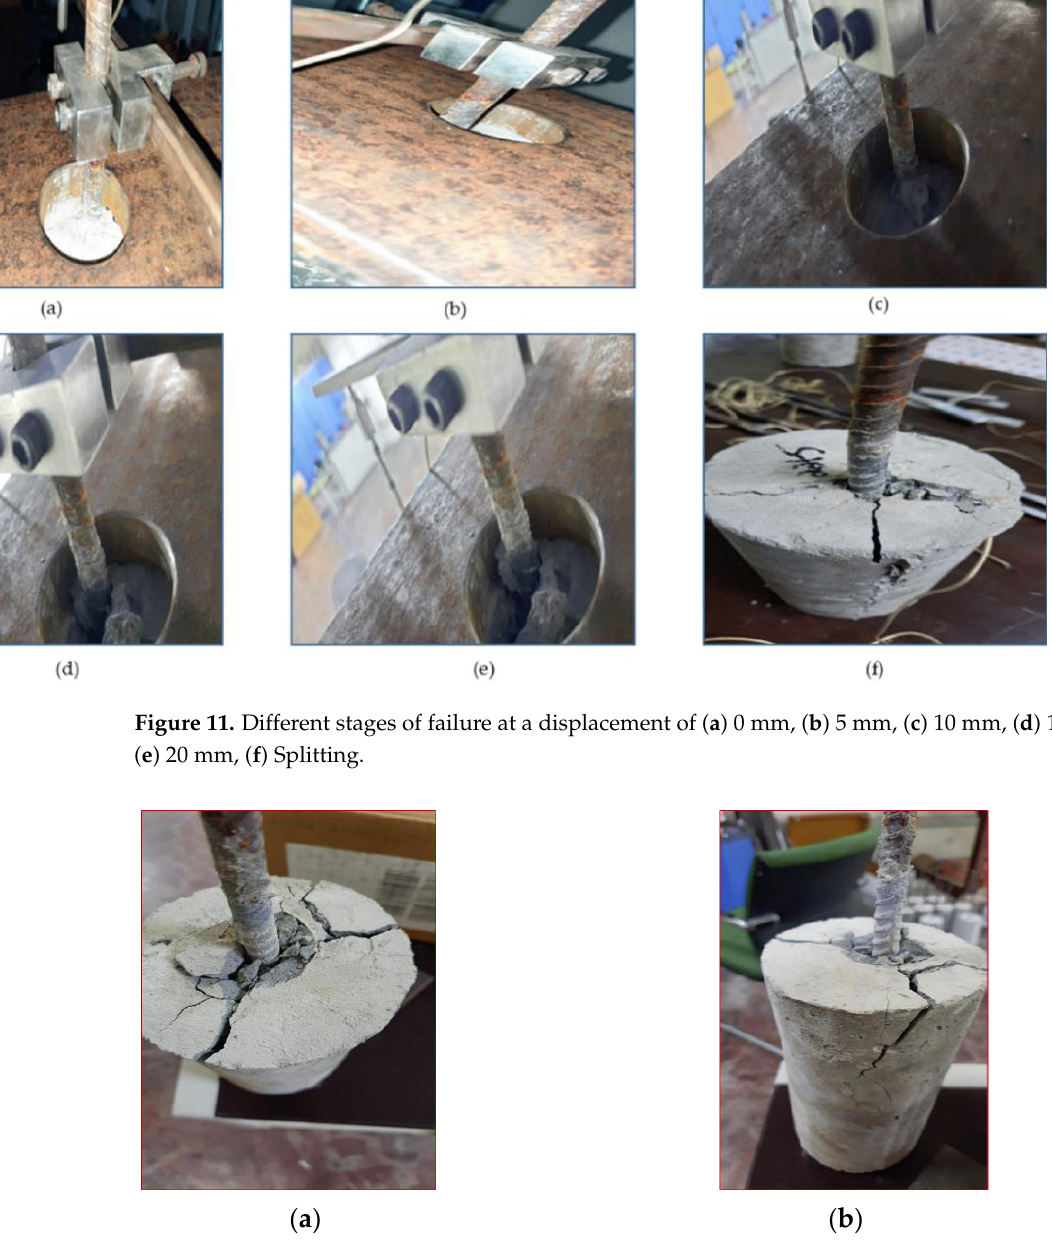
Figure 12. Different views of failure mode ( a ) Top, ( b ) Side.